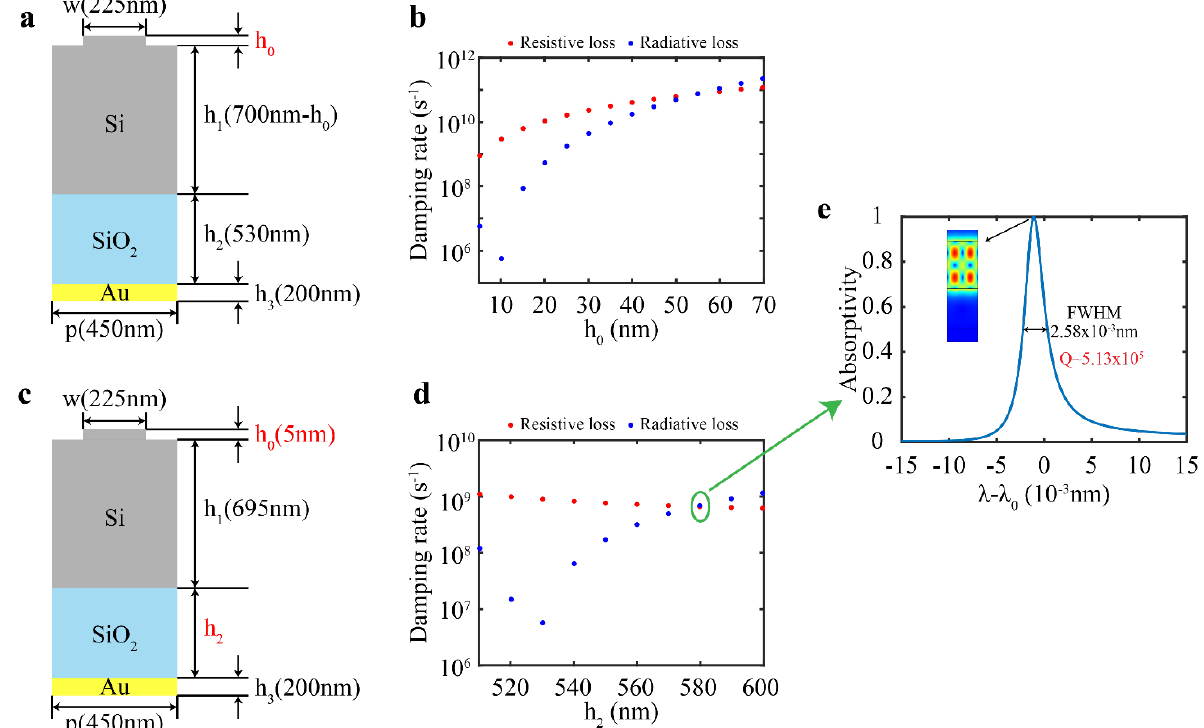
Figure 4. Design for increasing Q factor. ( a ) Schematic of the structure (grating thickness h 0 is the variable parameter). ( b ) Damping rates versus h 0 plots. Red and blue dots represent resistive and radiative losses, respectively. Grating thickness h 0 is varied from 5 nm to 70 nm, with an interval of 5 nm. ( c ) Schematic of the structure ( h 0 is set as 5 nm, and the SiO 2 layer thickness h 2 is varied). ( d ) Damping rates versus h 2 plots. SiO 2 layer thickness h 2 is changed from 510 nm to 600 nm, with an interval of 10 nm. ( e ) Absorptivity curve for the green circled structure parameter in ( d ). Inset represents the electric field distribution at the peak, λ 0 = 1323.375 nm.